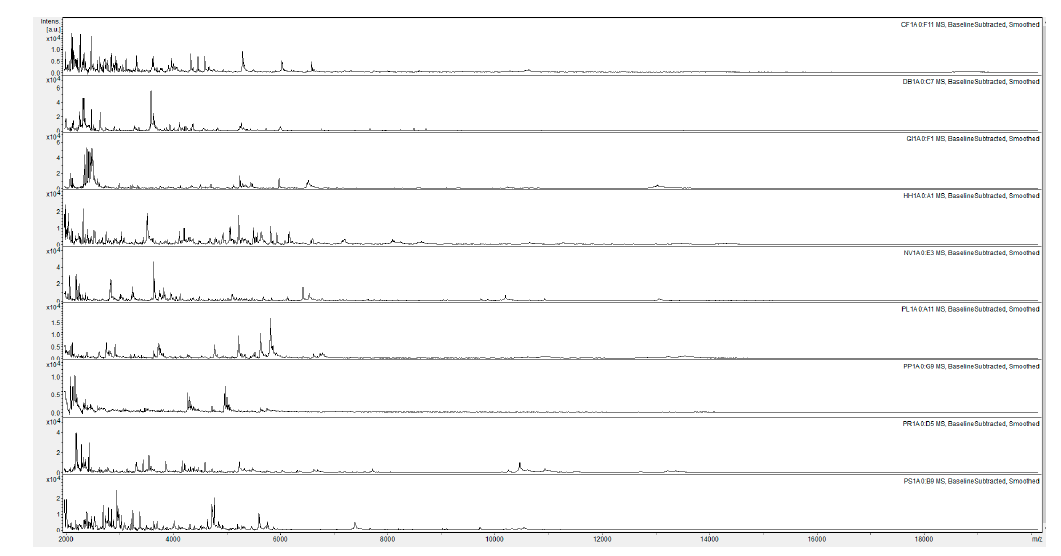
Figure 1. Replicate-1 MALDI-TOF MS spectra of acid-soluble egg proteins from nine species of stink bugs with, from top to bottom, CF = Carpocoris fuscispinus , DB = Dolycoris baccarum , GI = Graphosoma italicum , HH = Halyomorpha halys , NV = Nezara viridula , PL = Piezodorus lituratus, PP = Palomena prasina , PR = Pentatoma rufipes , and PS = Peribalus strictus . Spectra are shown baseline-subtracted, smoothed, with y-axis autoscaling, and covering the mass range 2 kDa to 20 kDa (with x-axis scale increments of 2 kDa). Figure 2 shows that the highest average Bruker score for each tested species is that of the cognate reference species. The differences between average Bruker scores are gener- ally large and the errors small except for C. fuscispinus (CF), D. baccarum (DB), and G. ital- icum (GI) (Figure 2a–c), where the average scores are lower and the errors higher relative to the remaining comparisons (Figure 2d–i). While there is clear discrimination between the nine species using this method, H. halys (HH) and P. lituratus (PL) are more spectrally related than the other pairwise comparisons.